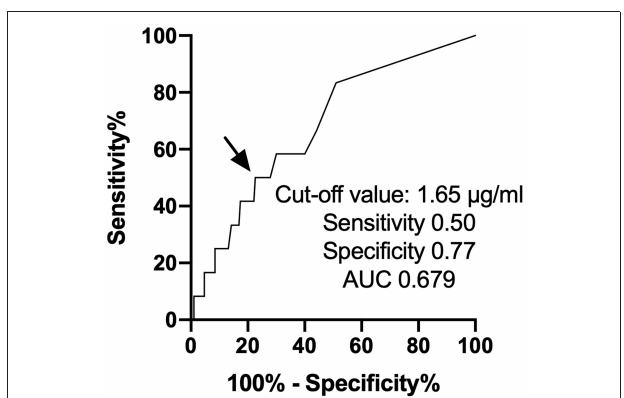
FIGURE 2 | ROC curve analysis of D-dimer predicting the occurrence of cancer therapeutics-related cardiac dysfunction. ROC, receiver operator characteristic